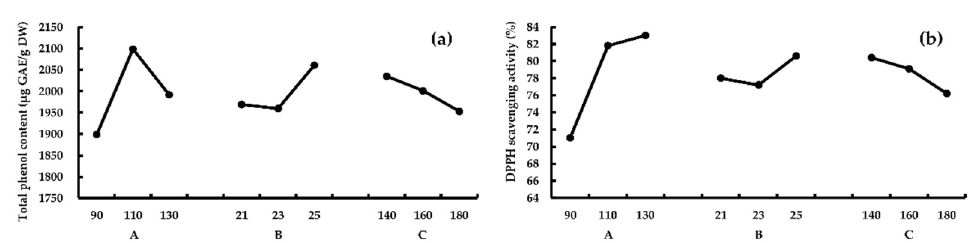
Figure 2. The e ff ect of di ff erent extrusion parameters on TPC ( a ) and AA ( b ). A, the third heating block Figure 2. The effect of different extrusion parameters on TPC ( a ) and AA ( b ). A, the third heating temperature ( ◦ C); B, feed water content (%); C, screw speeds (rpm). Table 4. Variance analysis of L 9 (3 4 ) orthogonal experiment for